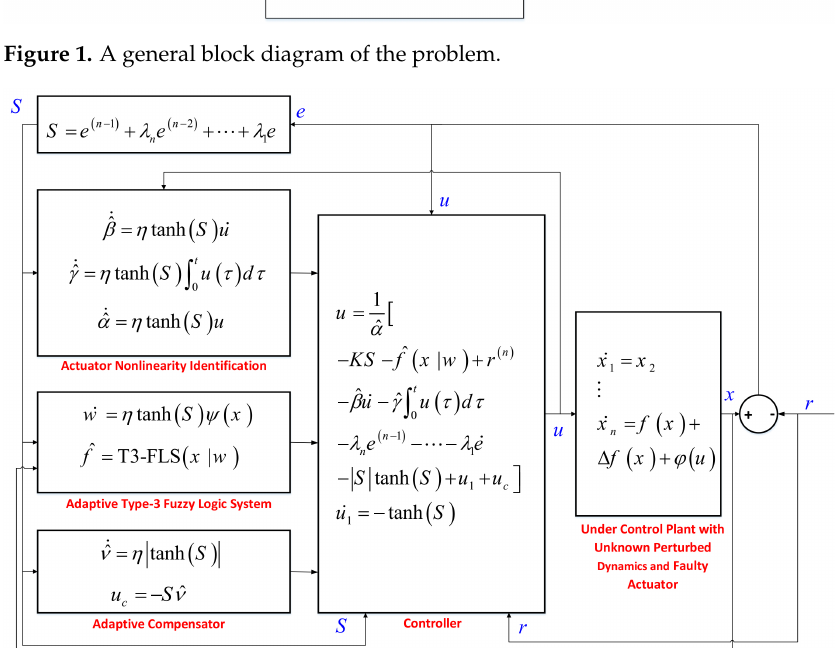
Figure 2. A general block diagram for the control